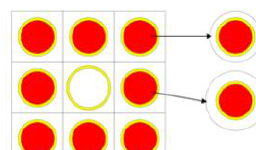
Figure 2. The Equivalence between a fuel pin cell in lattice and a 1D cylindrical fuel pin cell